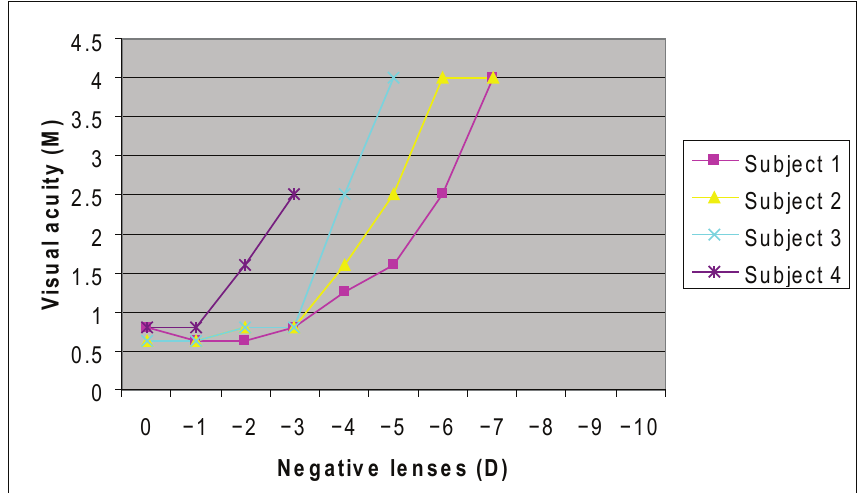
Figure 11. Effect of negative lenses on visual acuity while viewing a near acuity chart at 0.4 m through a pinhole with a 1.5 mm diameter and illumination of 1 lux.